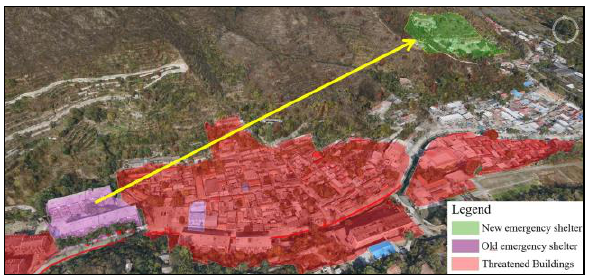
Figure 13 . Location movement of the emergency